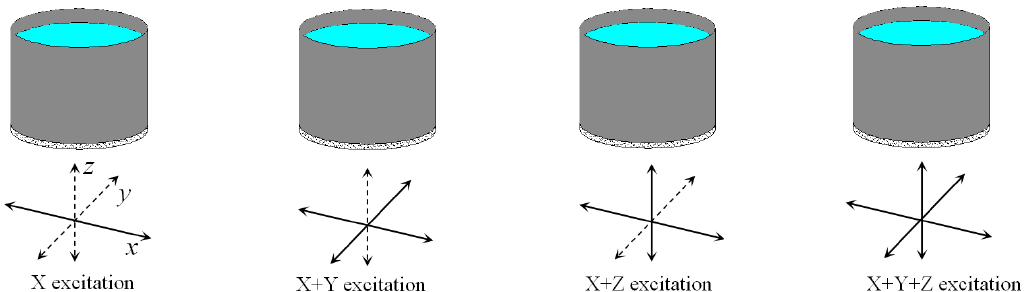
Table 3. Comparison of the peak response quantities under the four cases. Earthquake Excitation